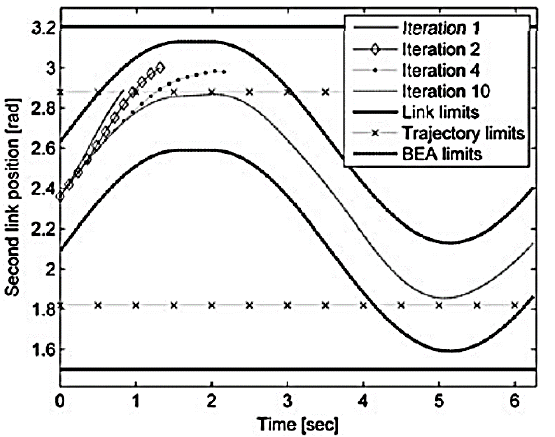
Figure 2. Hypercylinder around the trajectory